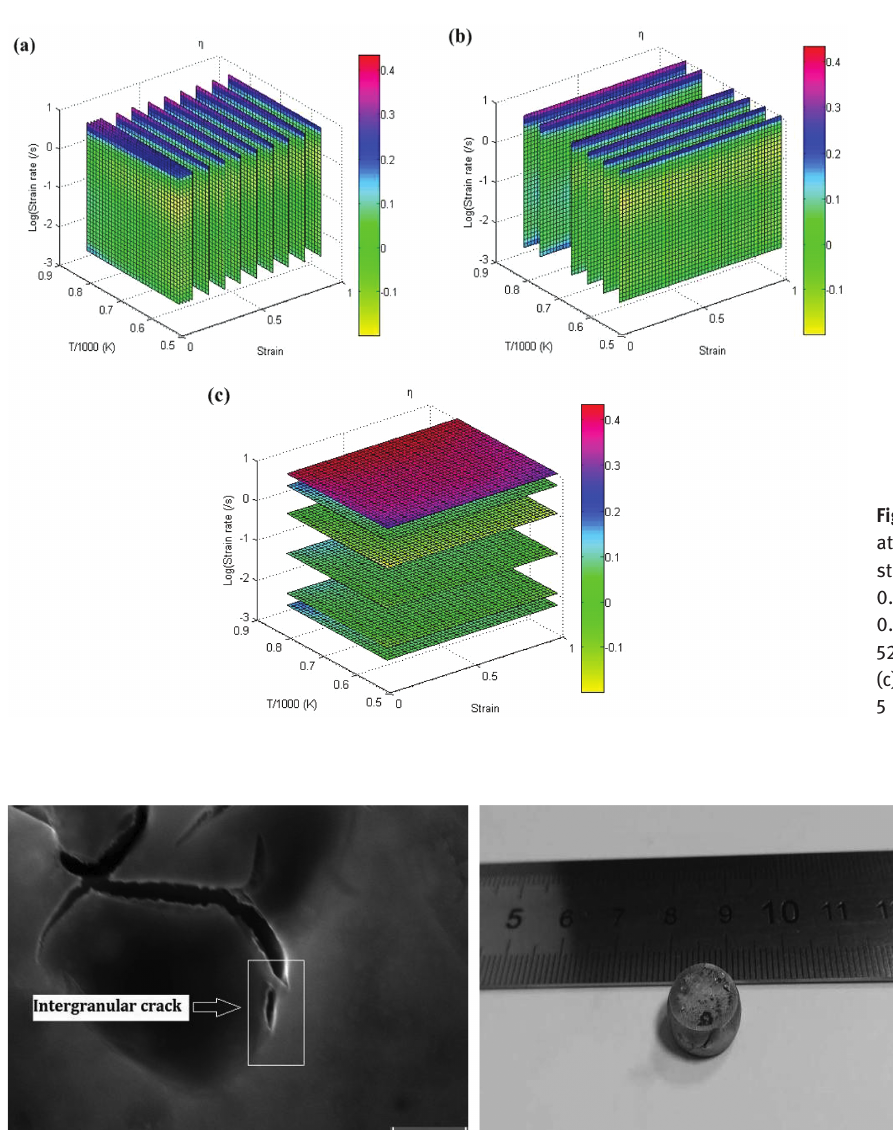
Figure 11: Surface cracking of pure aluminum deformed at 623 K/1s − 1